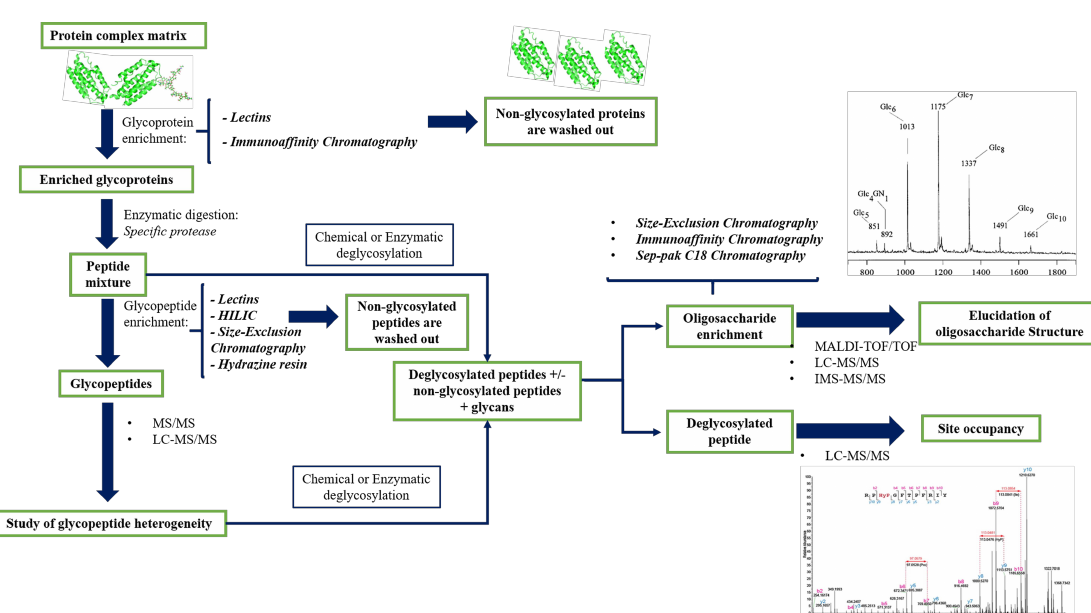
Figure 2. Workflow currently for mass spectrometry (MS)-based glycoproteomics